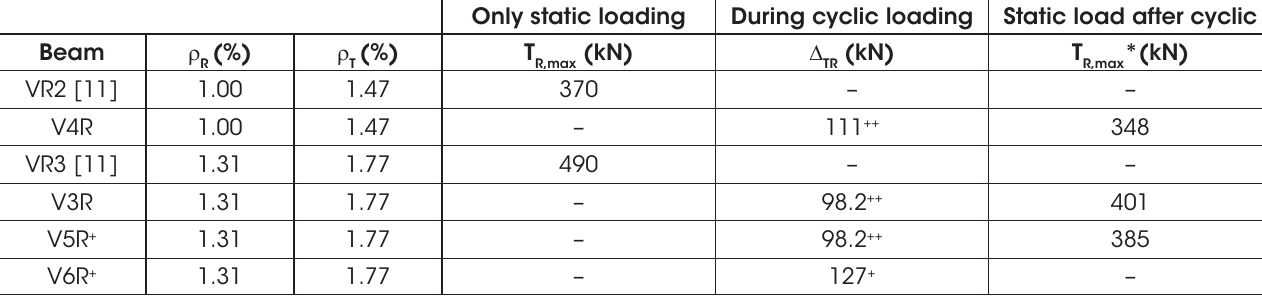
Values of T and D corresponding to static and cyclic loading R,max TR Only static loading During cyclic loading Static load after